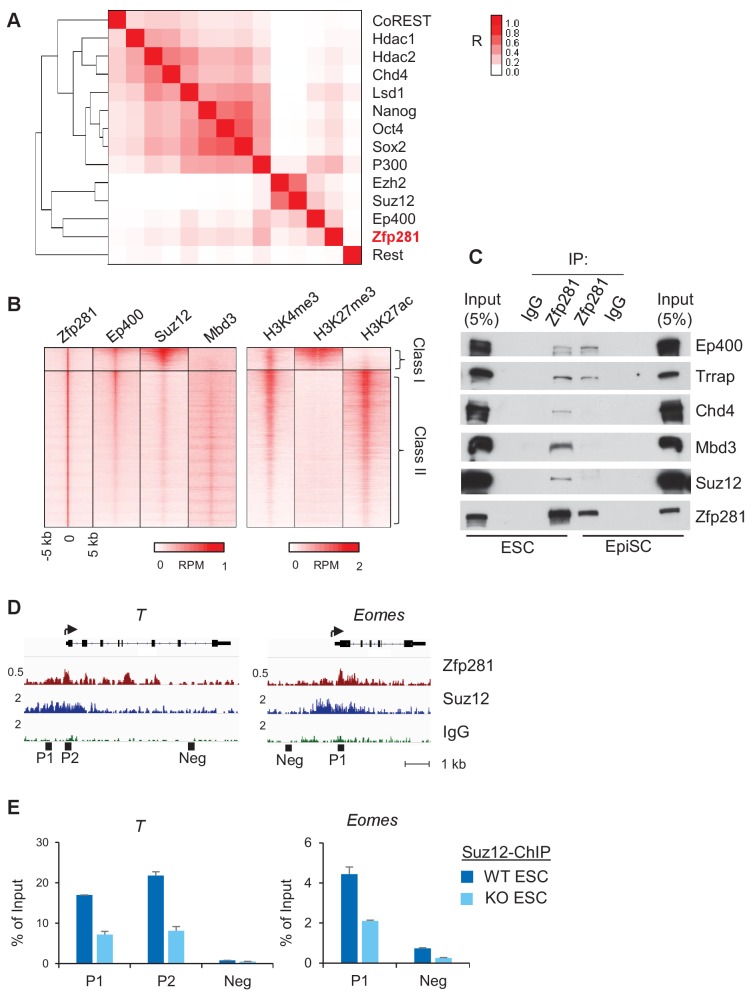
Zfp281 associates with PRC2 and Ep400 complexes for promoter regulation of bivalent lineage genes.(A) Heatmap of ChIP-seq association analysis of Zfp281 with other transcription factors and epigenetic regulators in ESCs. The ChIP-seq datasets were compiled from published studies (see Figure 6—source data 1 for the accessions). The scale represents Phi correlation coefficient. (B) ChIP-seq profiles of Zfp281, Ep400, Suz12, Mbd3, and histone marks H3K4me3, H3K27me3, and H3K27ac at Zfp281 peak regions. Intensity is plotted within 5 kb around Zfp281 peak center. Two classes of Zfp281 peaks are shown: Class I, Zfp281-Mll2-Ep400-Suz12 co-bound; Class II, Zfp281-Mll2-Ep400-Mbd3 co-bound. (C) Co-immunoprecipitation (co-IP) of Zfp281 with other epigenetic regulators in ESCs and EpiSCs. (D) ChIP-seq tracks of Zfp281 and PRC2 complex (Suz12) at bivalent T and Eomes promoters. (E) ChIP-qPCR shows Suz12 binding at T and Eomes promoters decreases in Zfp281KO ESCs.10.7554/eLife.33333.024Figure 6—source data 1.Accession numbers of ChIP-seq data used in Figure 6A.